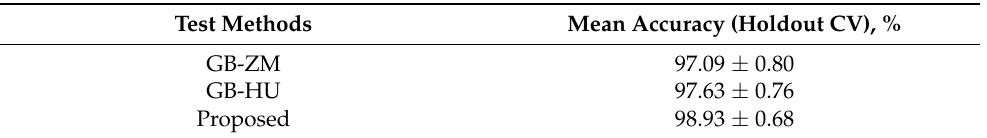
Table 4. Comparison of proposed technique with earlier techniques using holdout CV test on MU dataset.